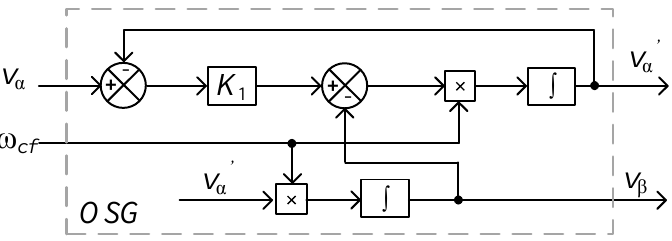
Figure 2. Second Order Generalized Integrator as Orthogonal Signal Generation (OSG).